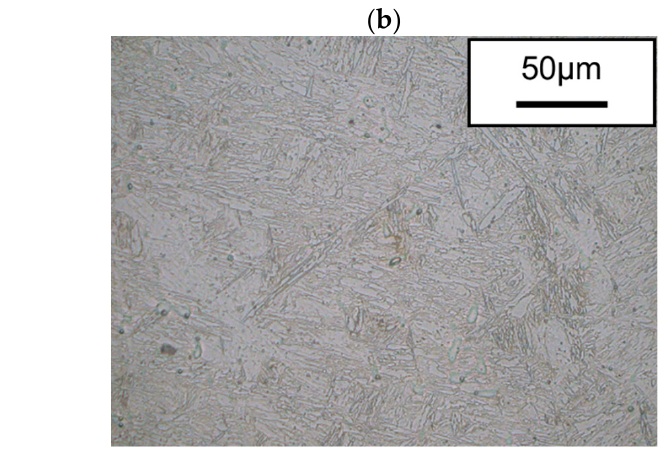
Figure 7. Microstructure of the materials as deposited ( a ) stainless steel SS 316L and ( b ) steel ER70.